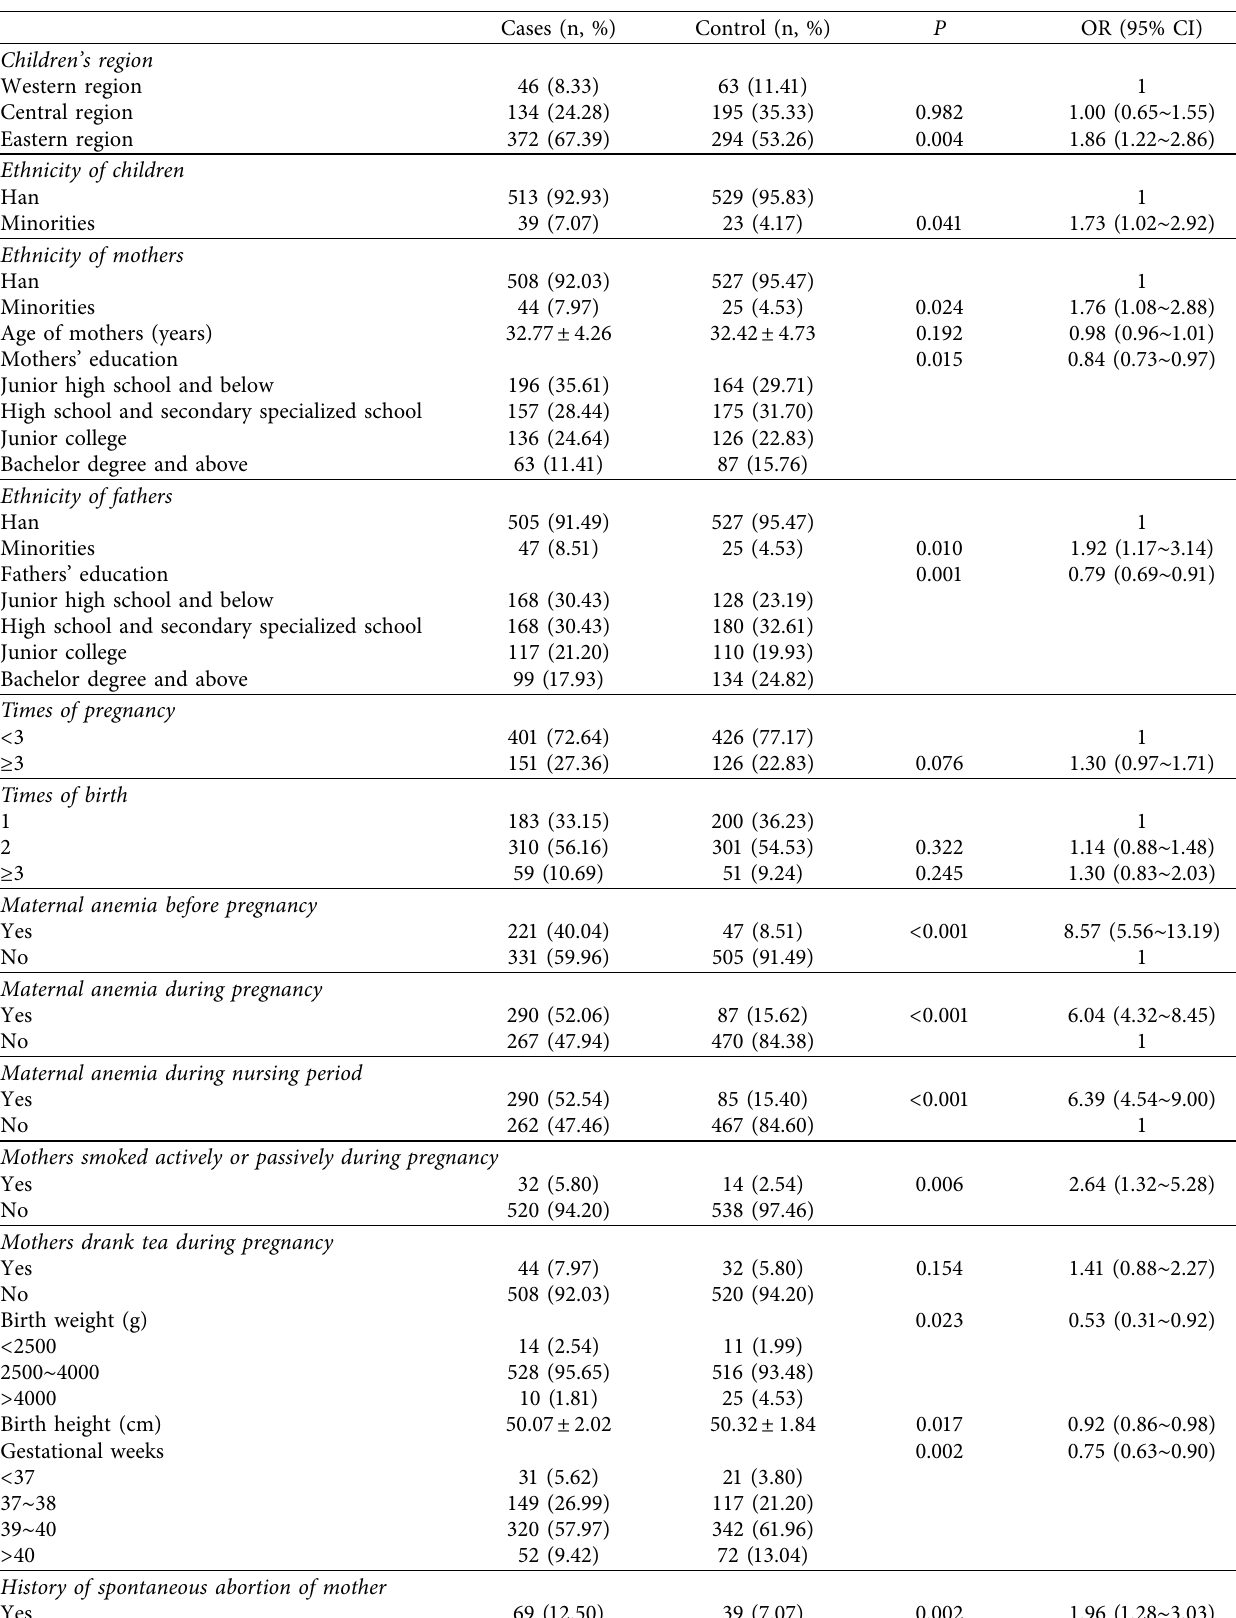
Table 2: Univariable analysis of determinants of anemia in children. Cases (n,